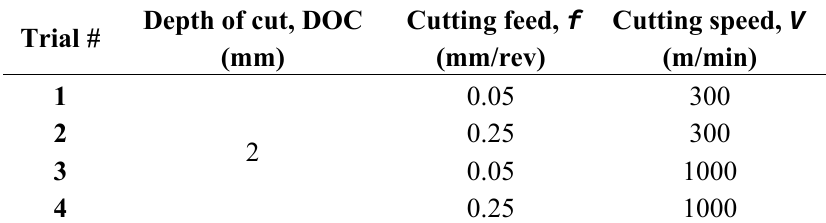
Table 3. Cutting